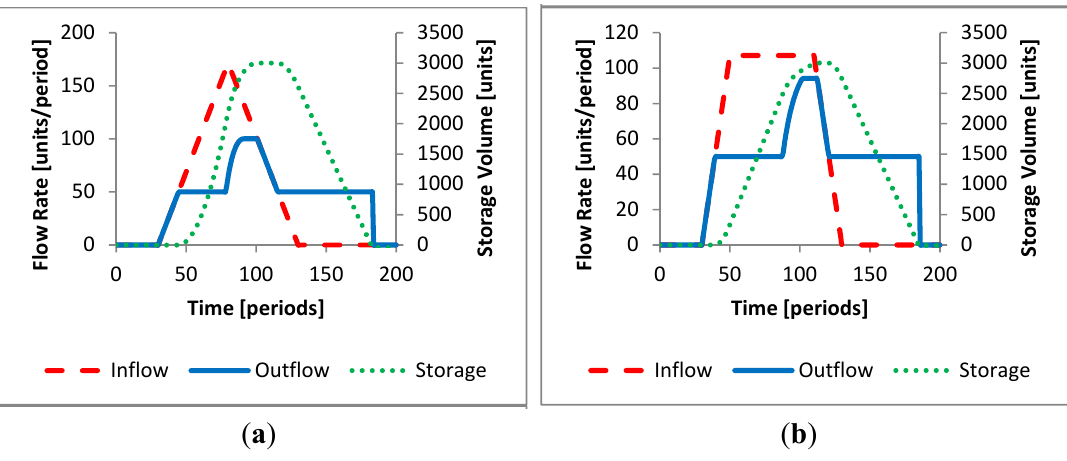
Figure 9. Short forecast peak minimization (when flooding occurs) for ( a ) Triangular hydrograph and ( b ) Broad peak hydrograph.